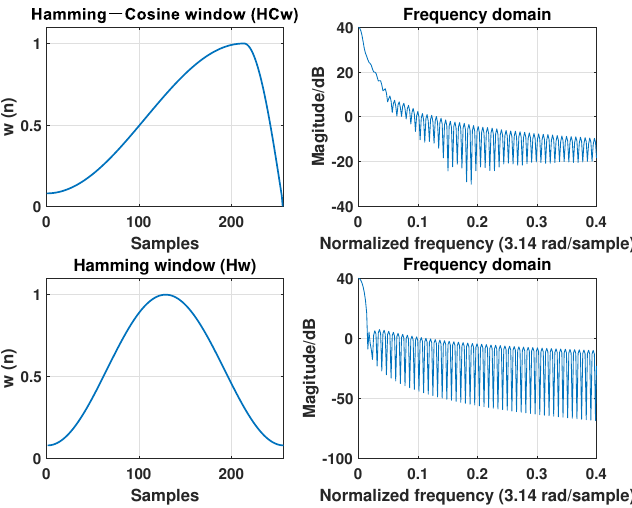
Figure 3. Comparison of Hamming and Hamming-cosine